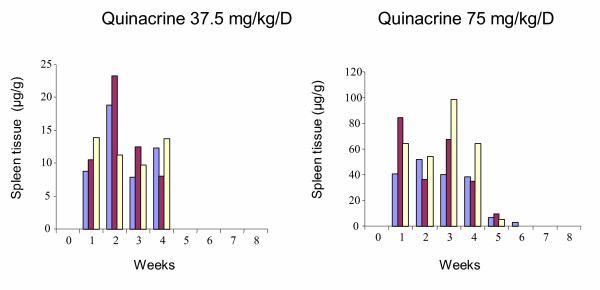
Quinacrine spleen levels in mice (FVB strain) administered oral quinacrine at 37.5 or 75 mg/kg/D for 4 weeks